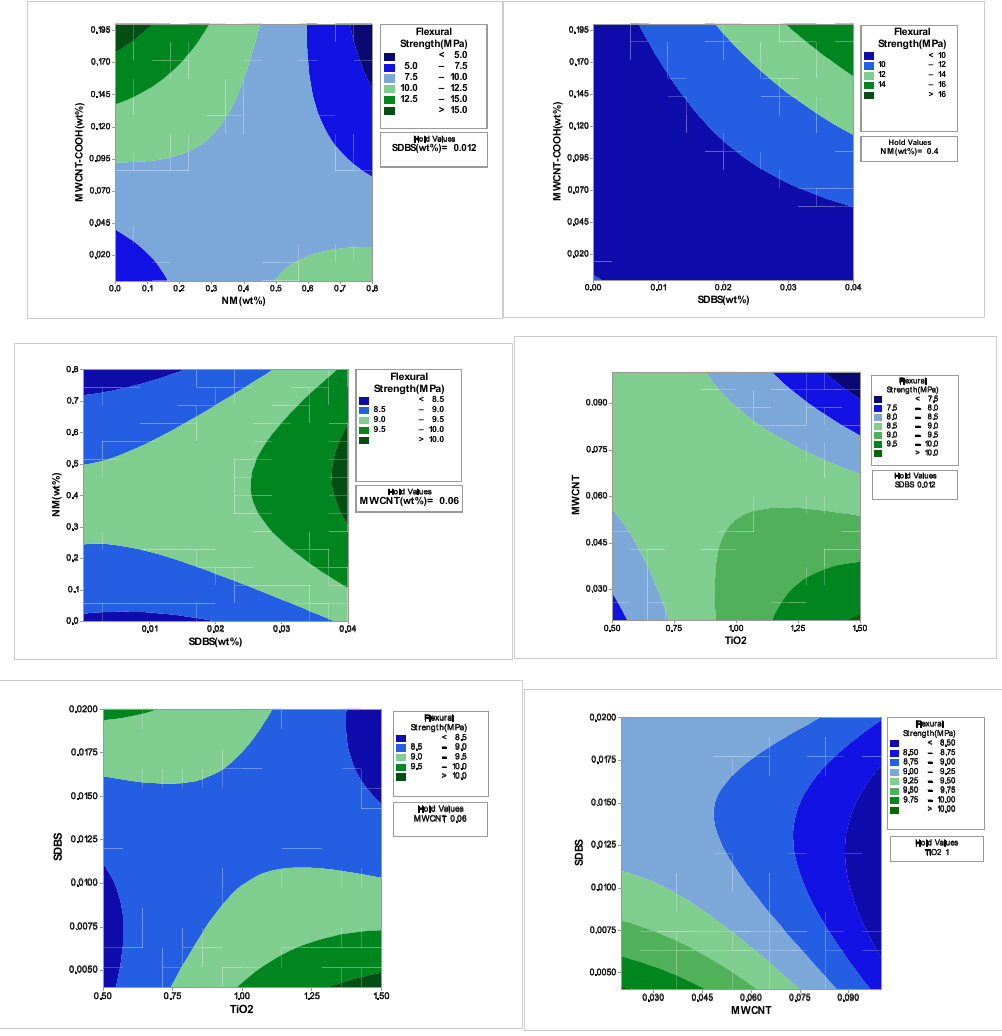
Fig. 11. Contour plots of flexural strengths versus nanomaterial Figure 11. Contour plots of flexural strengths versus nanomaterial interactions